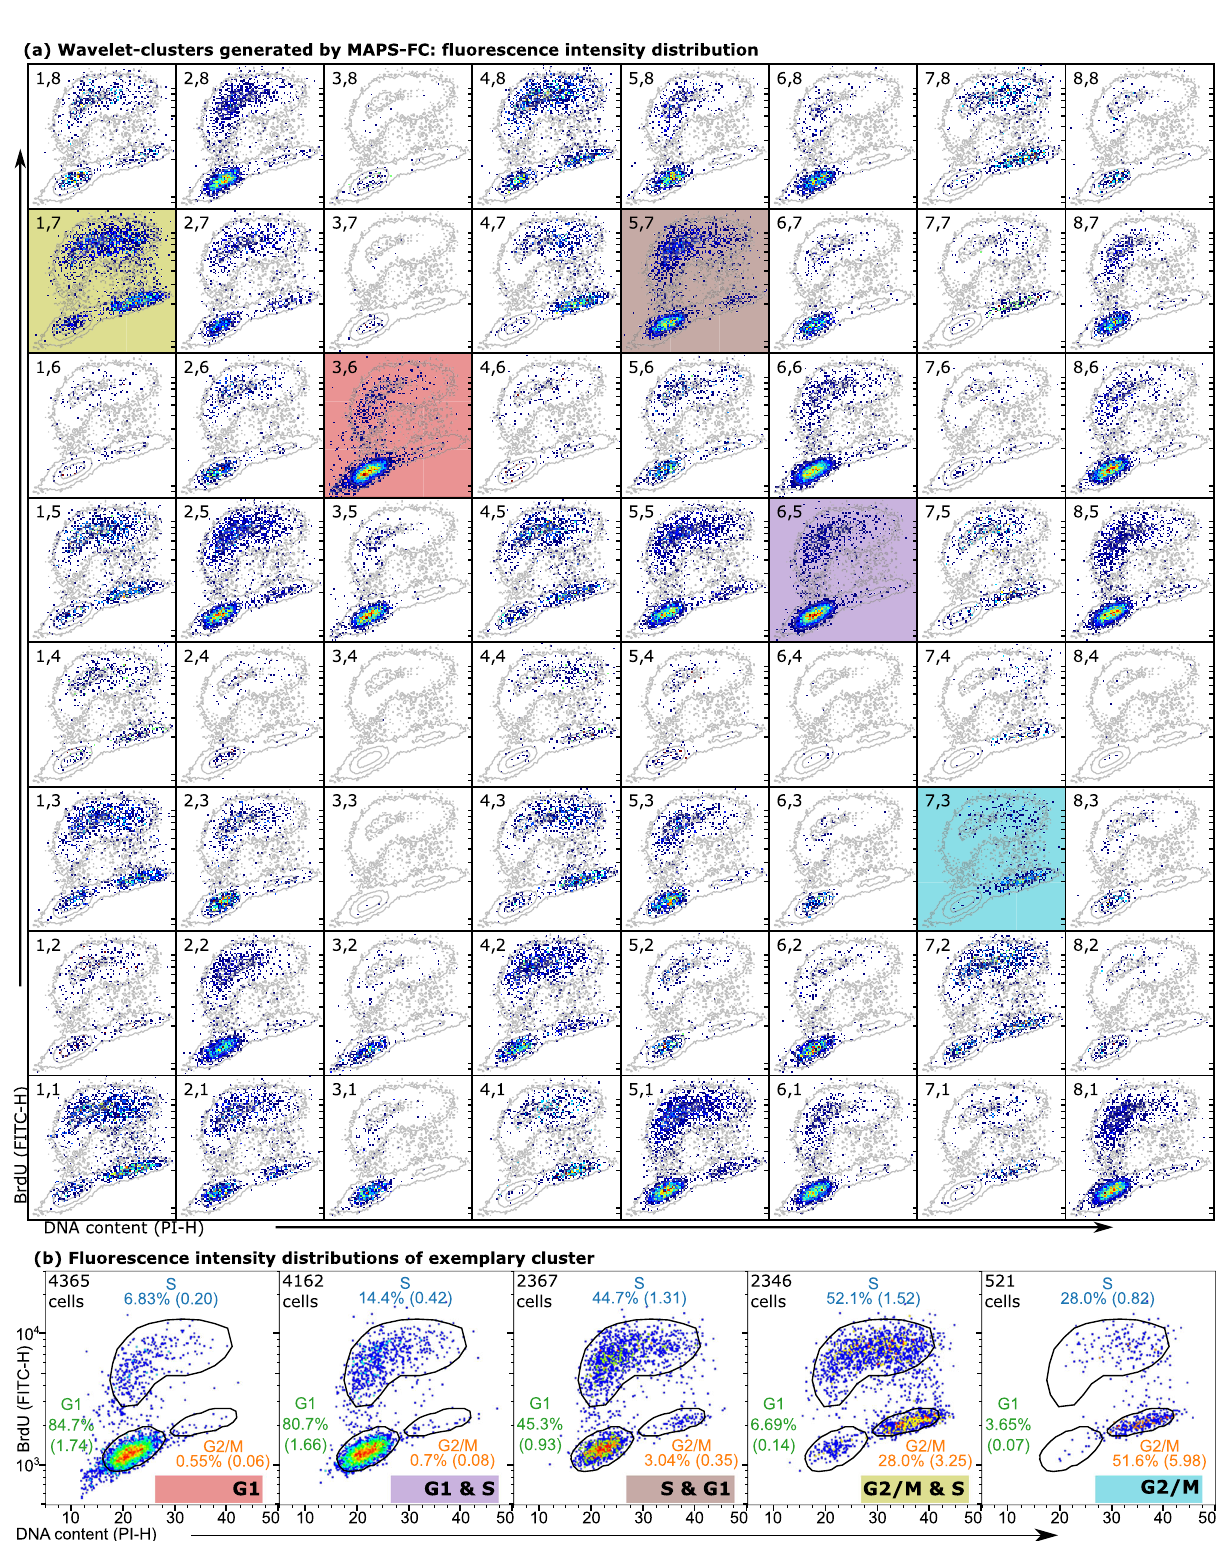
Fig. 2 Cell cycle analysis with MAPS-FC. a Pseudocolor dot plots of fl uorescence intensity in each combined cluster. The contour lines show the intensity distribution of all single cells. Cluster numbers are given in each subplot. b Fluorescence intensity plots of exemplary clusters from panel ( a ) with further details. Values in parenthesis denote enrichment